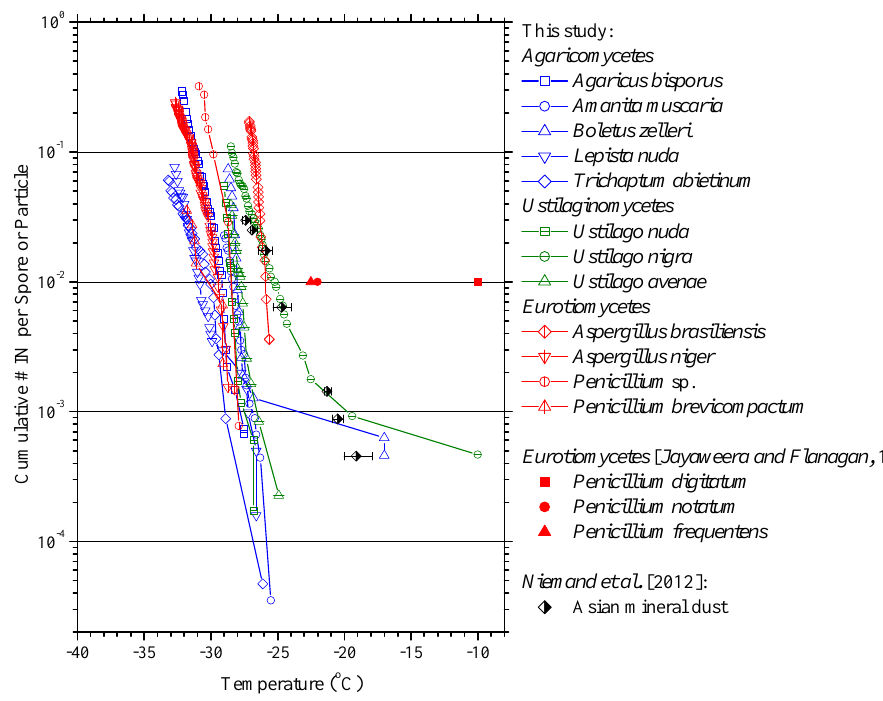
Figure 3. Cumulative number of ice nuclei per spore as a function of temperature, INperSpore(T) , as derived from the measurement data shown in Fig. 2. Agaricomycetes spores ( A. bisporus , A. muscaria , B. zelleri , L. nuda , and T. abietinum ) are in blue (open symbols); Usti- laginomycetes spores ( U. nuda , U. nigra , and U. avenae ) are in green (open symbols with a horizontal line); Eurotiomycetes spores ( A. brasiliensis , A. niger , Penicillium sp., and P. brevicompactum ) are in red (open symbols with a vertical line). Also shown is the INper- Spore(T) for Eurotiomycetes spores studied by Jayaweera and Flanagan (1982) (filled symbols), and the cumulative number of ice nuclei per particle INperParticle(T) for submicron Asian dust studied by Niemand et al. (2012) (half-filled diamonds).